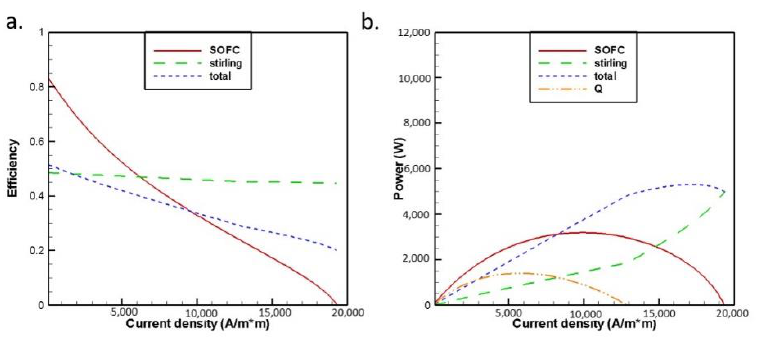
Figure 8. Computed ( a ) efficiency and ( b ) generated power for different current densities at 1173 K for the hybrid SOFC-SE system with heat components.